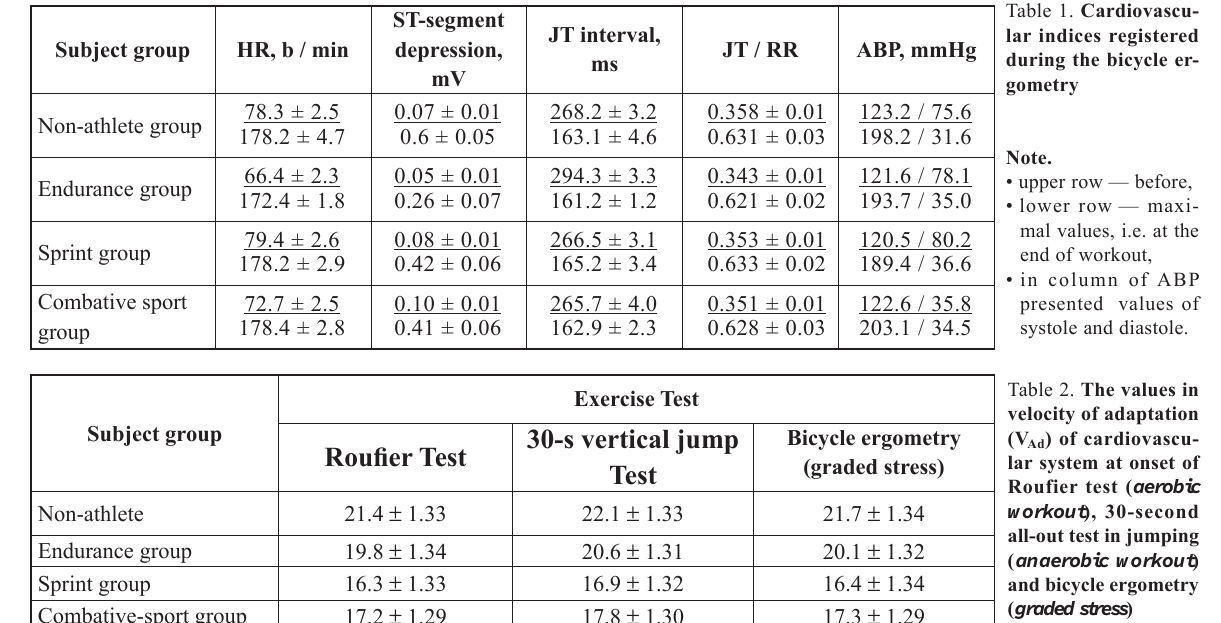
Table 1. Cardiovascu- lar indices registered during the bicycle er- gometry